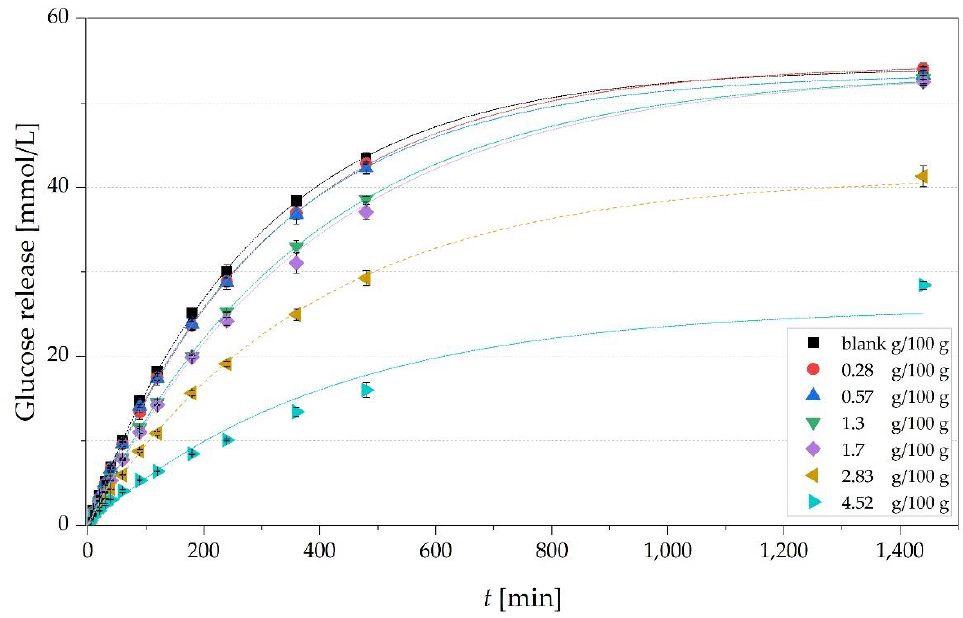
Figure 4. Time-dependent glucose release from solutions with different concentrations of CMC-L (0.28 – 4.52 g/100 g; blank = 0 g/100 g). 1.3 g/100 g is the calculated c * concentration of CMC-L. Points correspond to experimental data and lines to fitted data according to equation 3 (R 2 ≥ 0.9998).